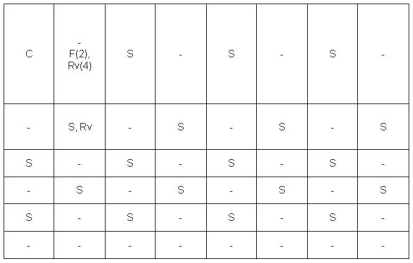
Position of contamination observed in MODS Plates.C. Positive control (H37Rv), S. Sample, F. Contaminated with fungi, Rv. Contaminated with H37Rv, Rv(4). Four experiments contaminated with H37Rv at this position.